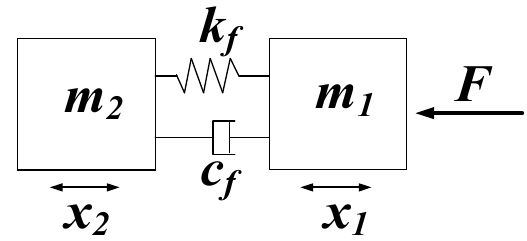
Figure 4. Simplified dynamic model of the piezoelectric pump with elastic inlet and outlet.